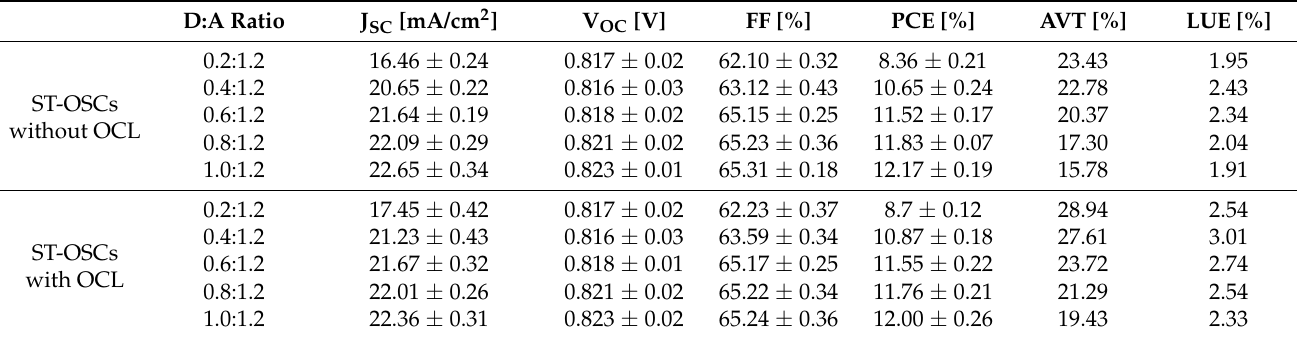
Table 2. Summary of photovoltaic parameters measured for the ST-OSCs prepared using BHJ layers having different weight ratios of PM6 to Y6 with an OCL and without an